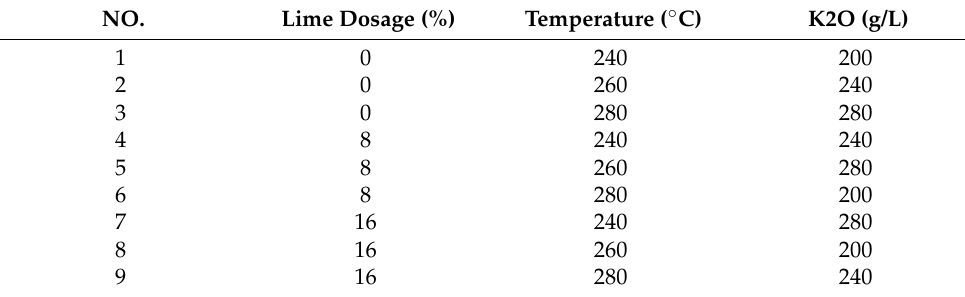
Table 4. Design of L 9 (3 4 ) orthogonal